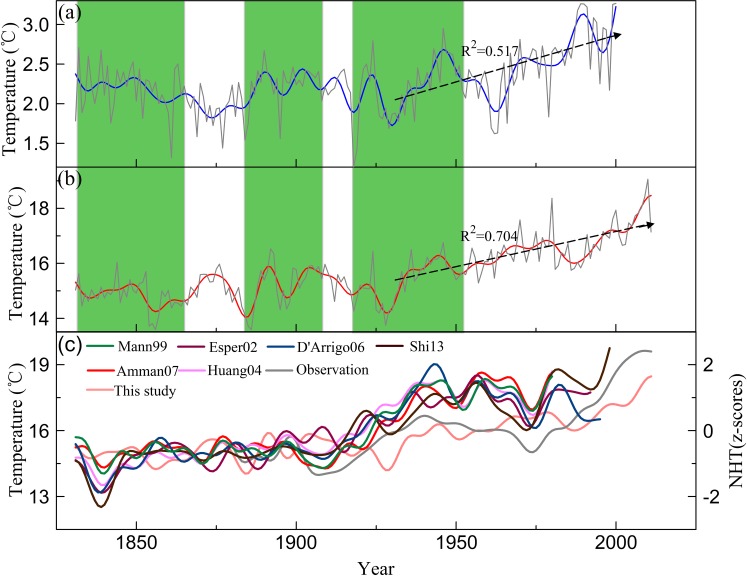
Comparison between the mid-eastern Tibetan Plateau temperature (a), the reconstructed temperature (b), and the NH temperature (c). All time series were smoothed using a 10-year low-pass filter. Vertical bars in (a) and (b) indicate when the two temperature series are in-phase, and the dashed line with an arrow indicates the linear fitting values during the period 1931–2011.